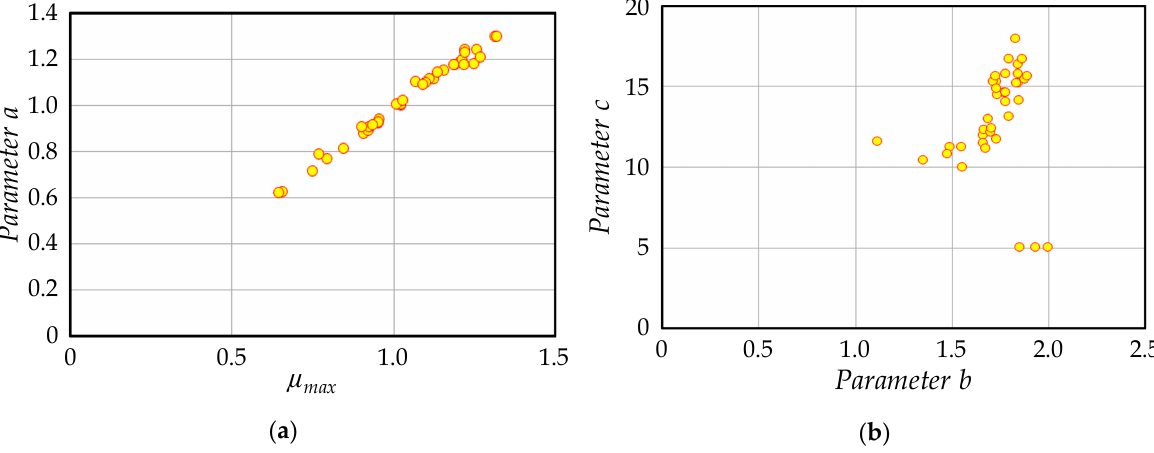
Figure 11. MF parameters identified from experimental data. ( a ) Relation between μ max and parameter a . ( b ) Relation between parameter b and c.